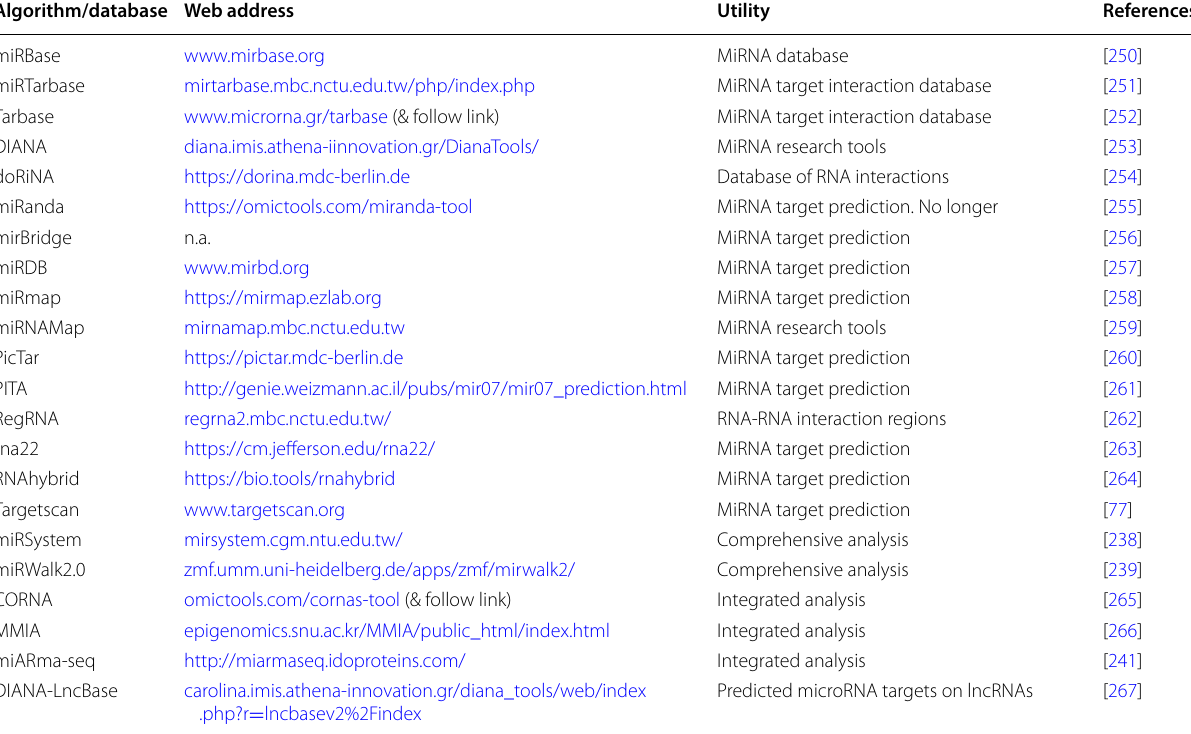
Shown are algorithms and databases for the prediction of miRNA targets, and for the comprehensive and integrated analysis of miRNA/mRNA interactions (see main text). This is not an exhaustive list, and the selection only reflects author’s preferences